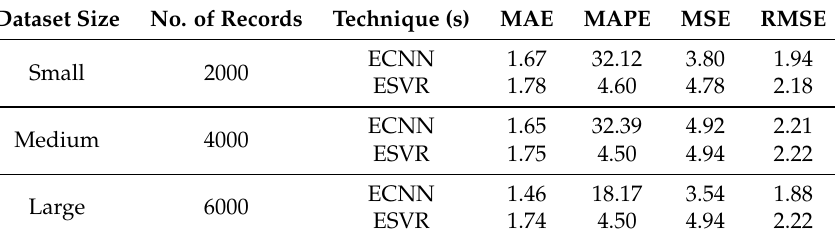
Table 8. Effect of Size of Dataset on Performance.